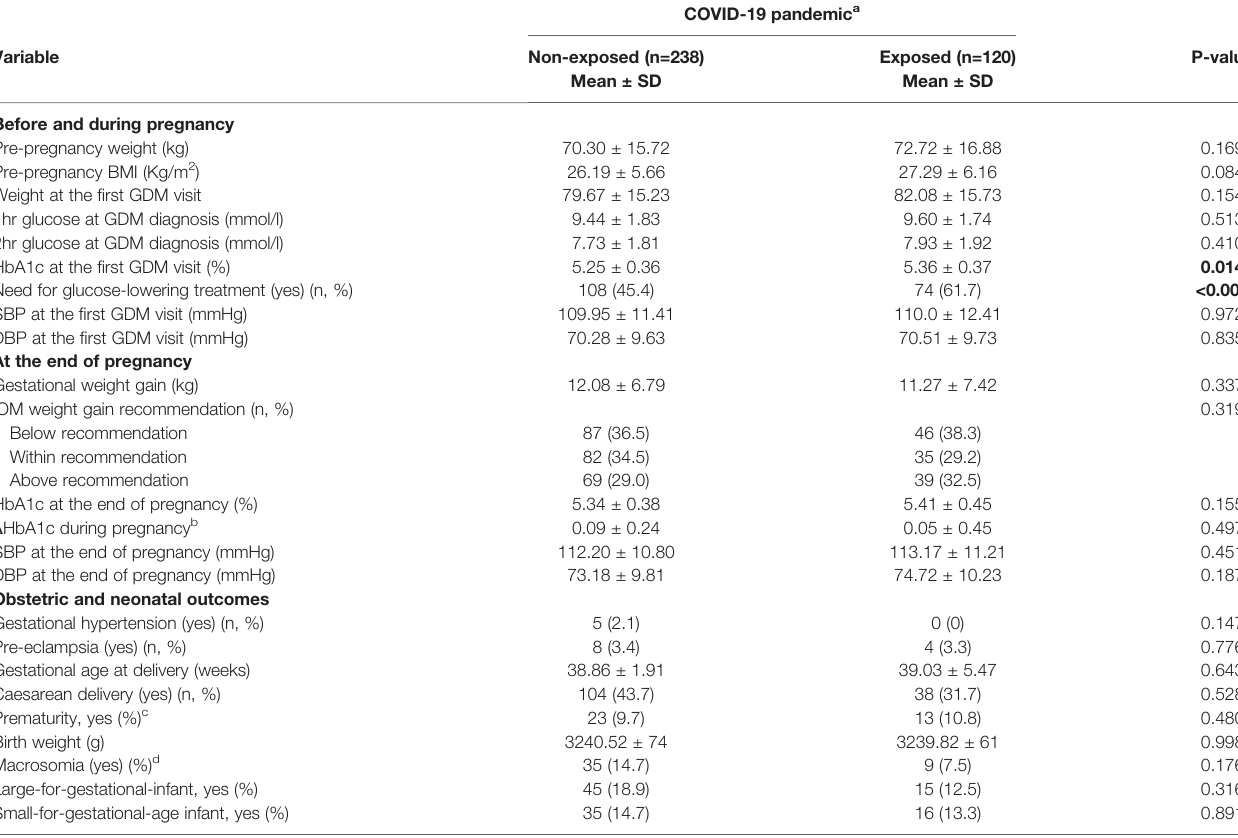
COVID-19 pandemic a